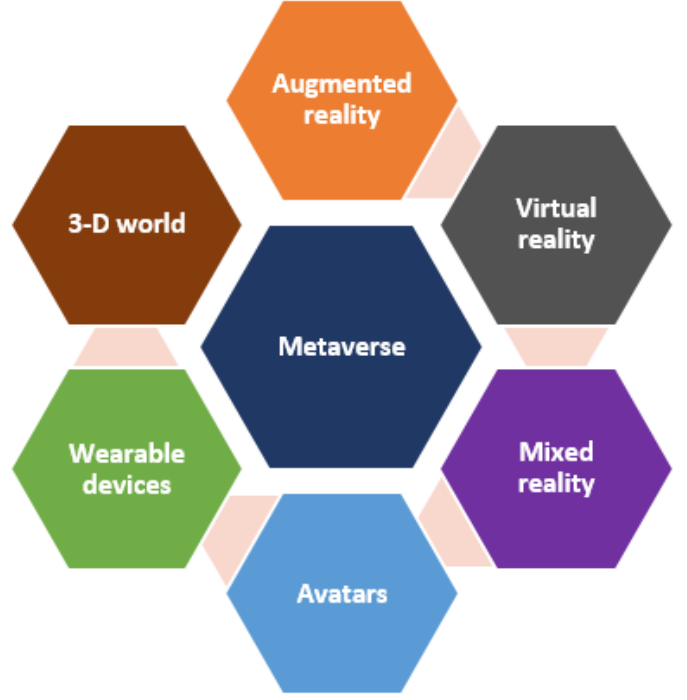
Figure 1. Illustration of Metaverse technology.